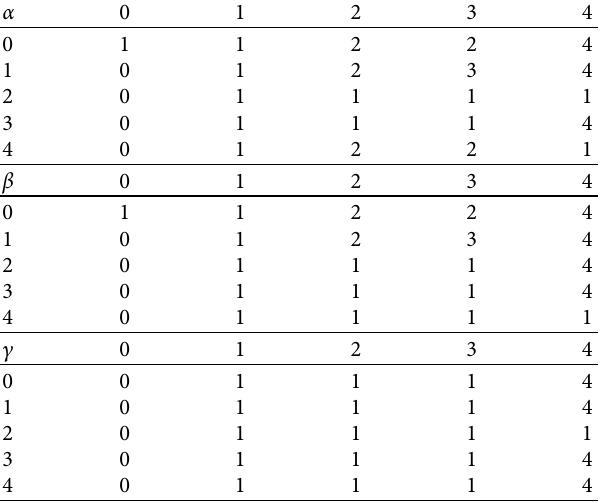
Table 10: Cayley tables for the binary operations “ α , β , and c .”